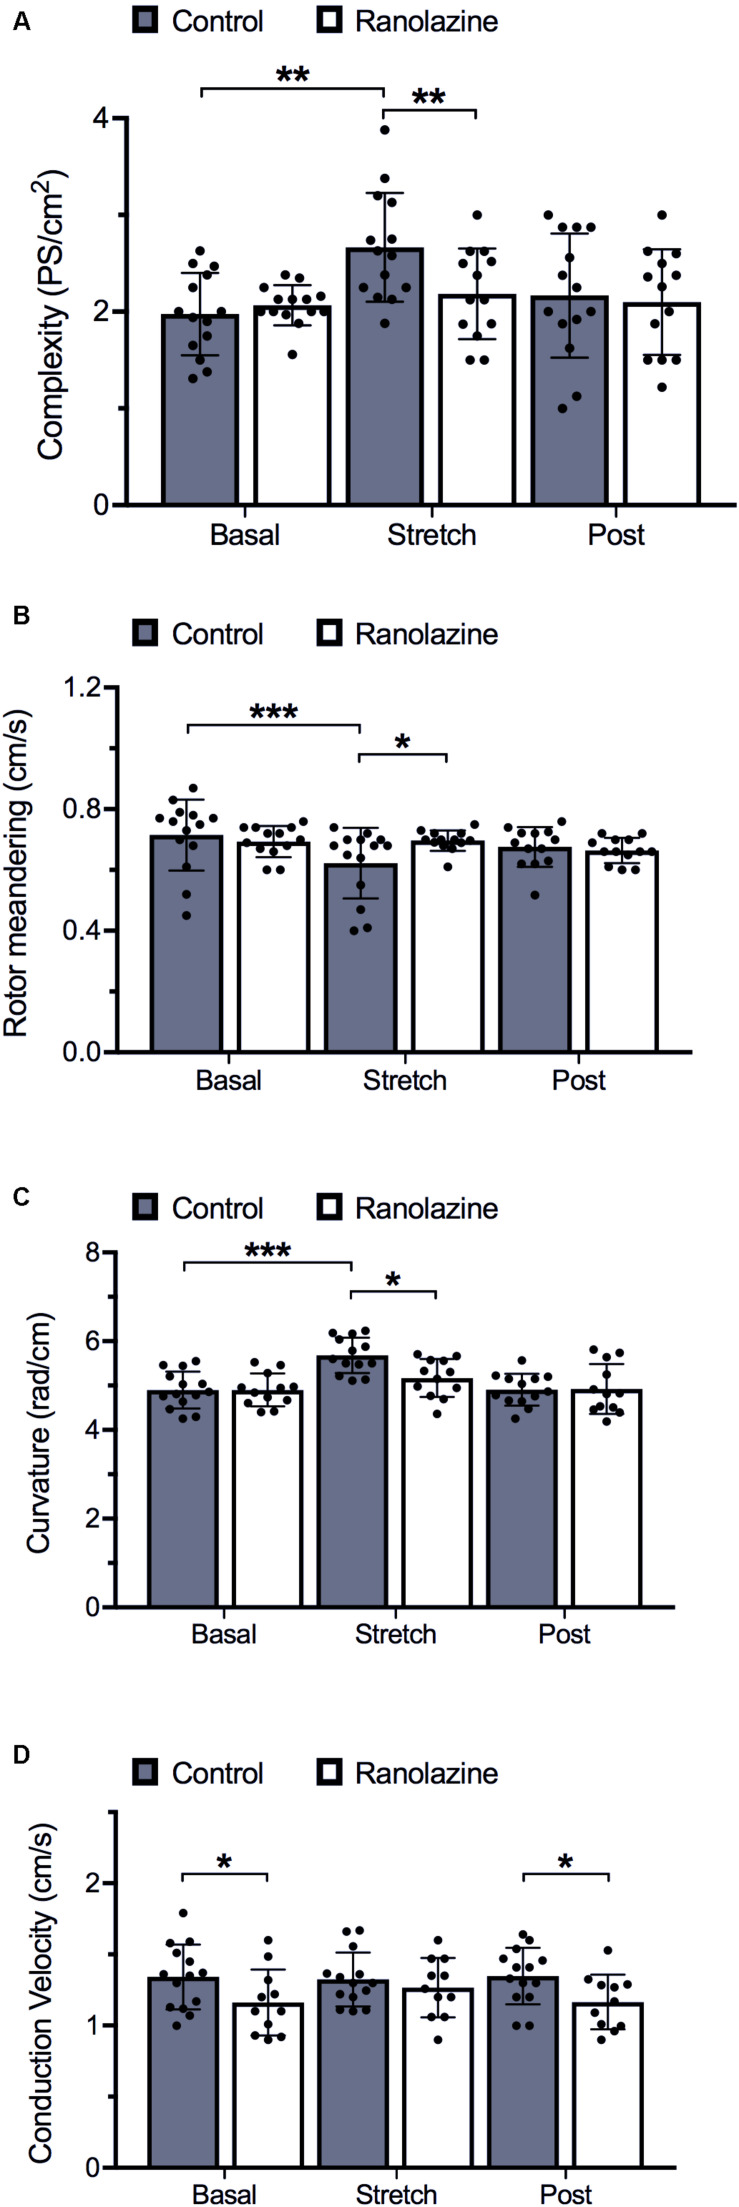
Quantification of activation pattern characteristics of cell cultures obtained under control and ranolazine conditions, for basal, stretch (3rd minute), and post-stretch (3rd minute) situations (mean ± standard deviation) (n = 14). (A) Complexity measured as the number of simultaneous phase singularities per square centimeter. (B) Rotor meandering (mean distance traveled for each rotor tip over time). (C) Rotor curvature. (D) Conduction velocity. *p < 0.05, **p < 0.01, ***p < 0.001.